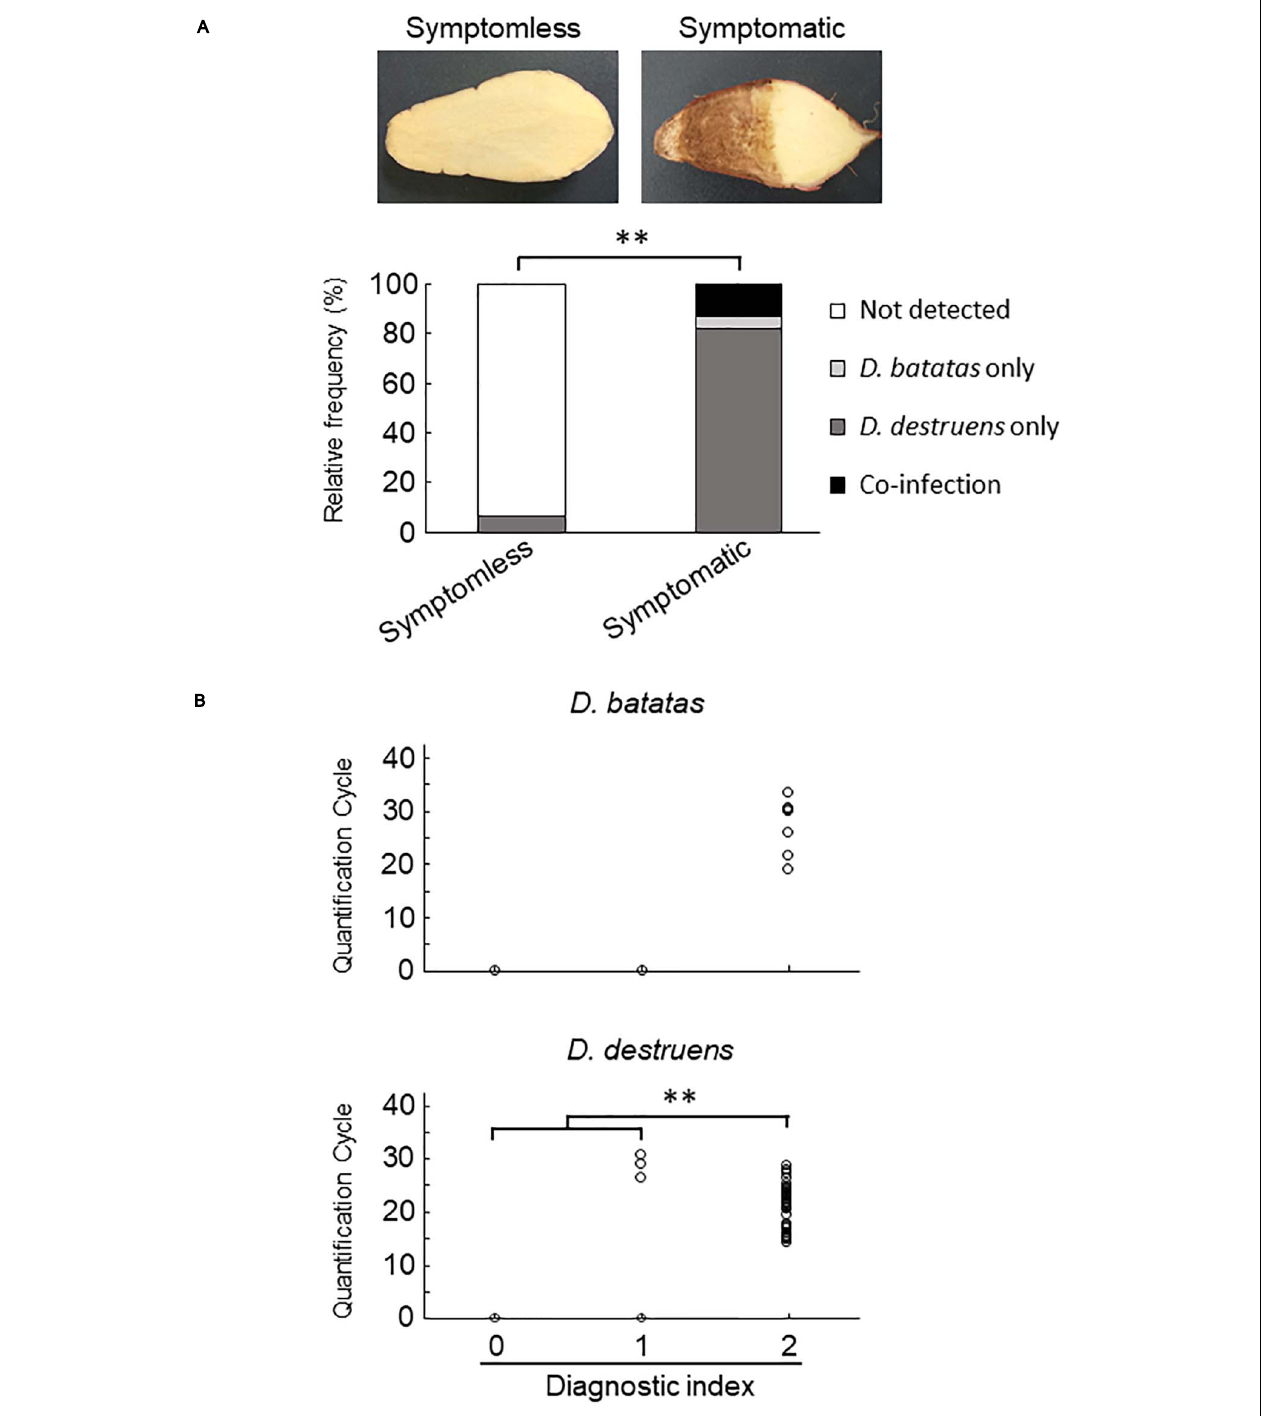
FIGURE 5 | Frequency of amplification of D. batatas and D. destruens DNA from naturally infected sweet potato tubers. (A) Relative frequency of D. batatas and D. destruens detection in sweet potato tubers with or without symptomatic disorder. Detection frequency of the two pathogens among symptomless and symptomatic tuber tissues was highly differentiated ( n = 83, ∗∗ P < 0.01, Fisher’s exact test). (B) Amplification of D. batatas and D. destruens DNA from naturally infected sweet potato tubers in the field. Diagnostic index of sweet potato tubers scored on a scale of 0 to 2 along with real-time PCR detection using the new primer sets (0, symptomless with no pathogen detected; 1, symptomless but pathogen detected; and 2, symptomatic disorder with pathogen detected). The concentration of D. destruens in tubers with diagnostic index 2 was significantly higher than in those with the index 1 ( n = 83, ∗∗ P < 0.01, Steel–Dwass test), while there was no statistical significance in D. batatas